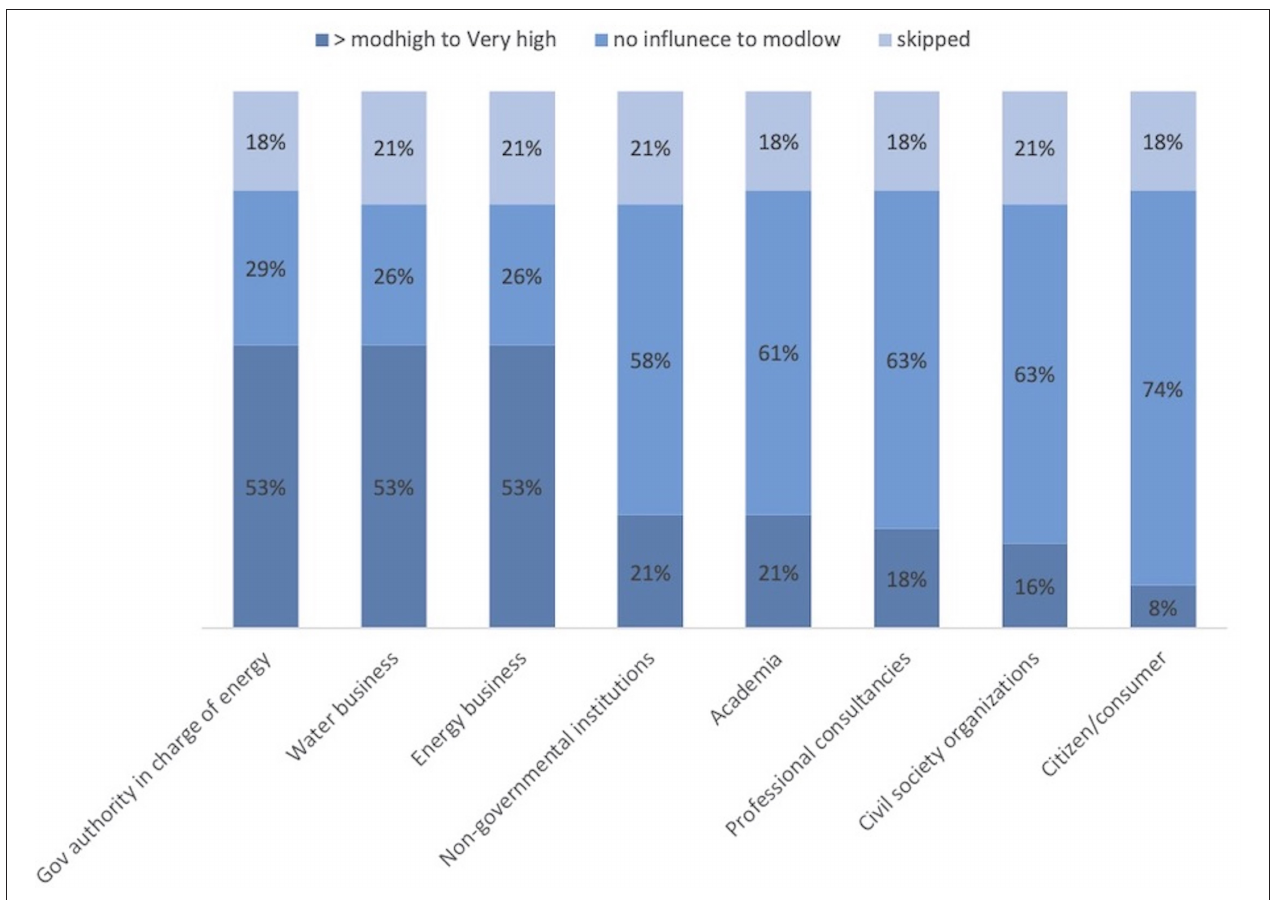
FIGURE 7 | Stakeholder views on non-integrated areas of water and